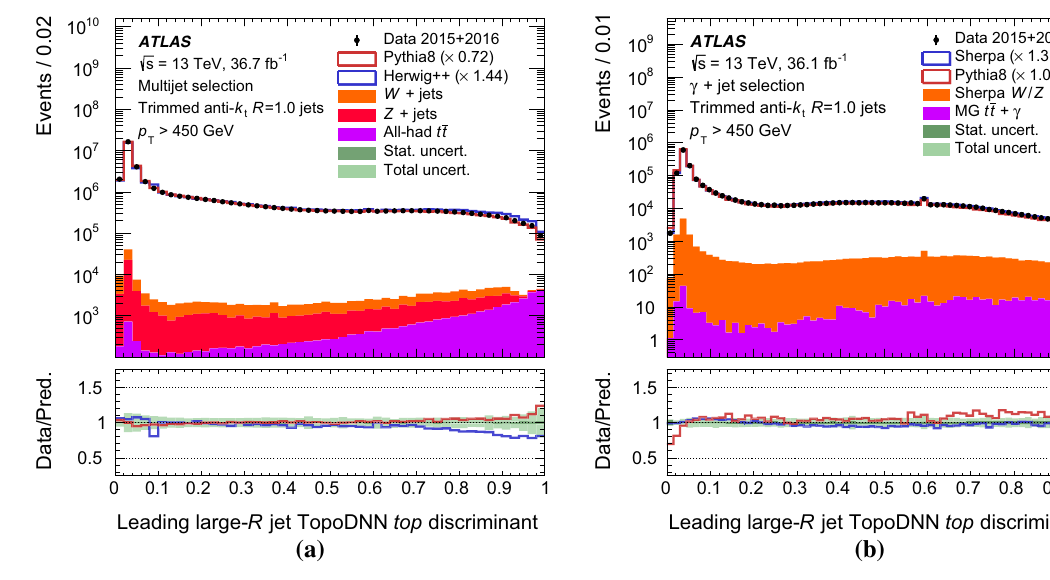
the legend beside the specific sample to which it applies. Systematic uncertainties are indicated as a band in the lower panel and include all experimental uncertainties related to the selection of events, as well as the reconstruction and calibration of the large- R jet